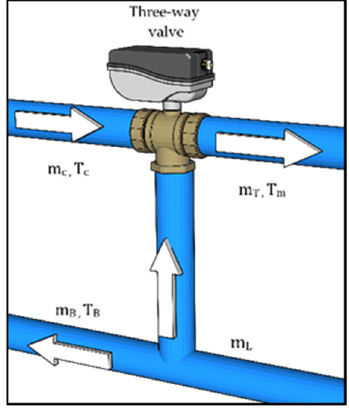
Figure 8. Cooling water flow in three-way valve.